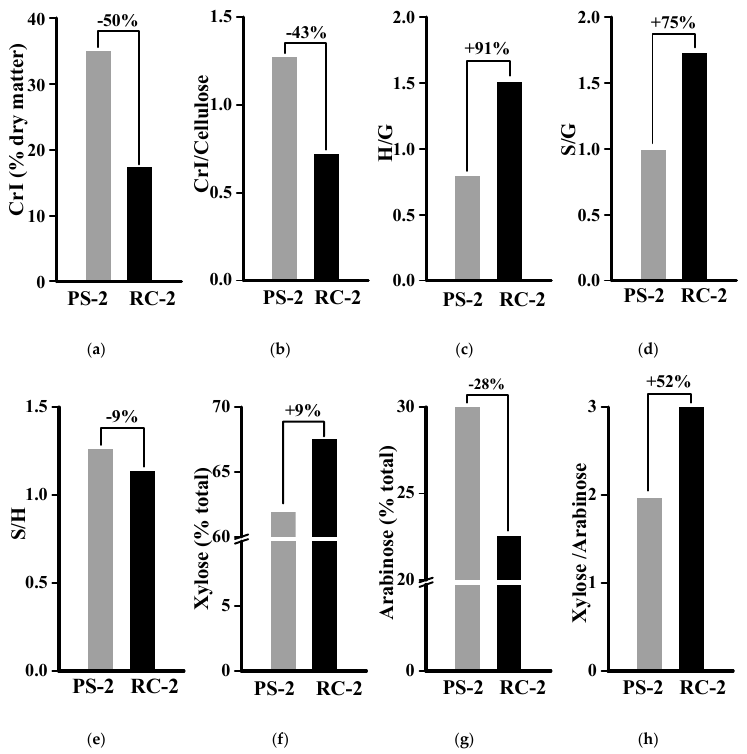
Figure 7. Comparison of major wall polymer features between PS-2 and RC-2 samples. ( a ) Cellulose CrI against dry matter; ( b ) CrI against cellulose level; ( c – e ) three lignin monomer ratios; ( f , g ) xylose and arabinose levels of hemicellulose; ( h ) xylose/arabinose ratios. ± was calculated by subtraction between PS-2 and PS-4 values divided by PS-2. Data as mean SD ( n ± 3).